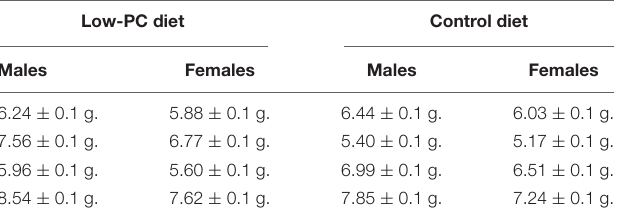
100 squares, with a 0.04 µ 2 for each square, was placed on the microscope eyepiece. The grid was superimposed on